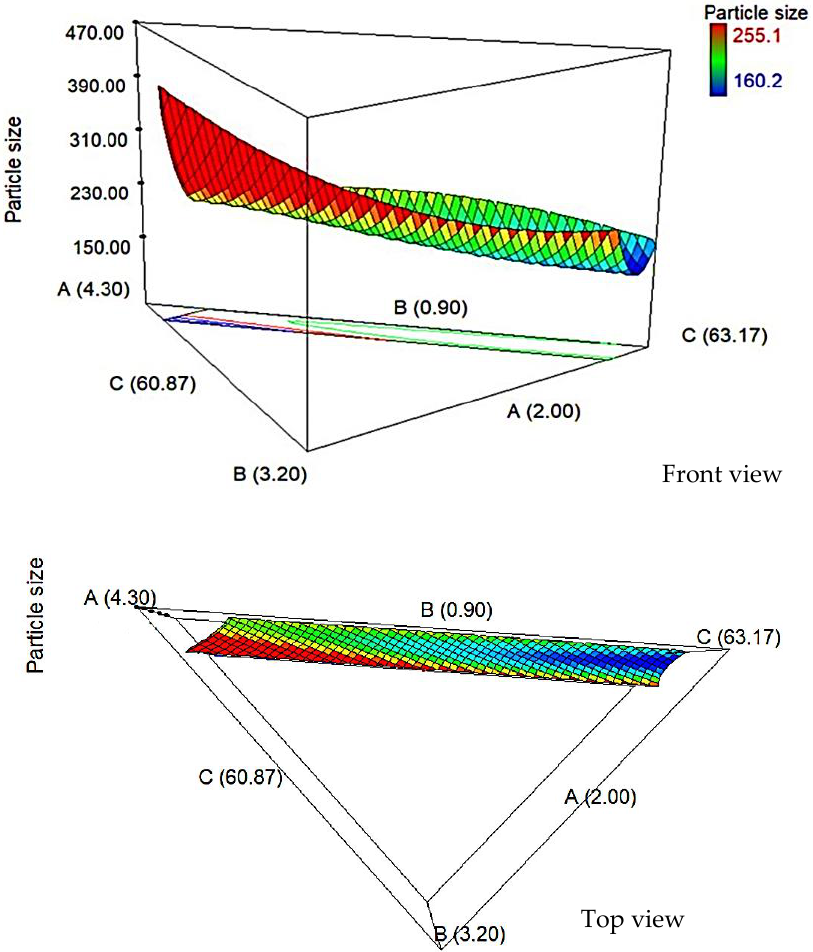
Figure 1. 3D surfaces showing the interaction effect of the surfactants (A), cholesterol (B), and glycerol solution (C) against particle size.